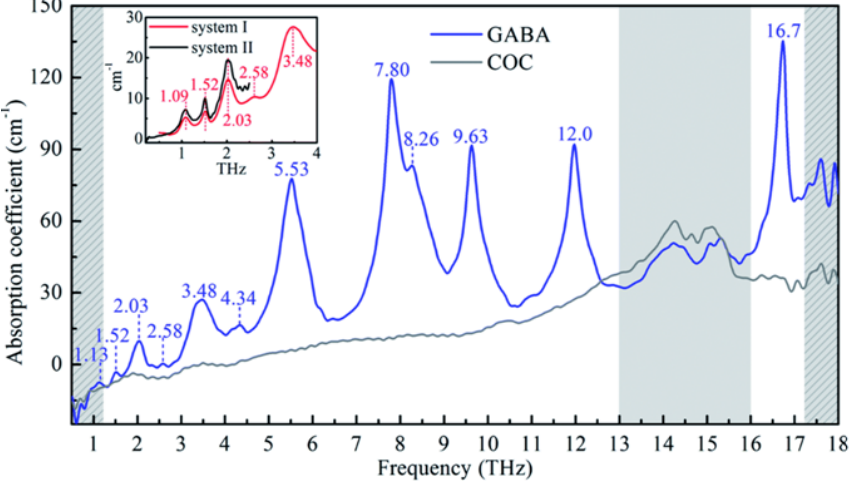
Figure 11. The THz absorption spectra of 4-Aminobutyric acid (GABA) and cyclic olefin copolymer (COC) obtained by the broadband air-plasma THz system at 293 K. The inset one was obtained by the TAS7400TS THz system (system I) and the photoconductive switch THz system (system II) (the gray area indicates the contribution of a substrate to the absorption. The absorption in the gray slash area is for reference only). Reprinted from [161].